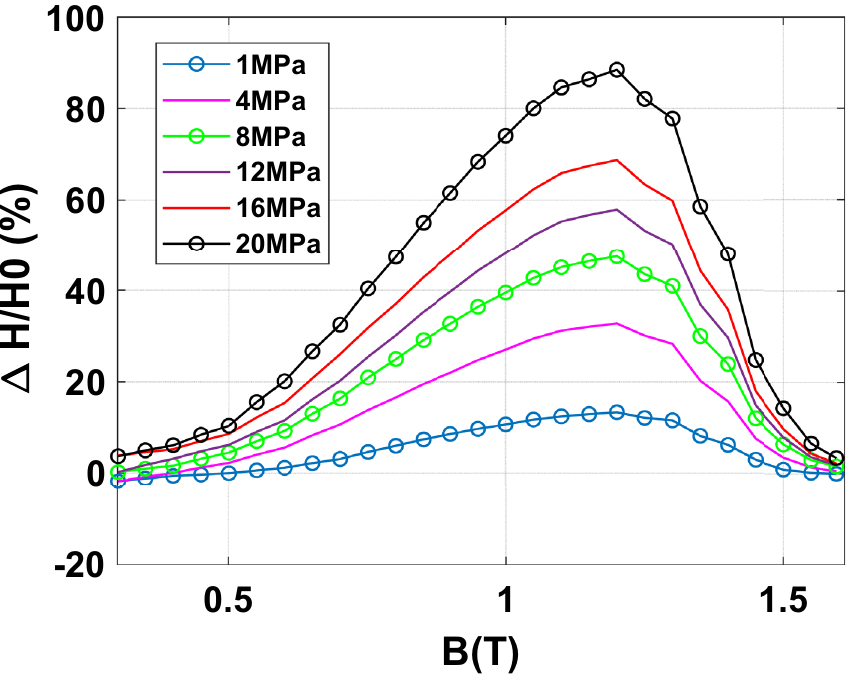
Figure 18. Relative difference on magnetic field due to compaction 50 Hz - Homogeneous